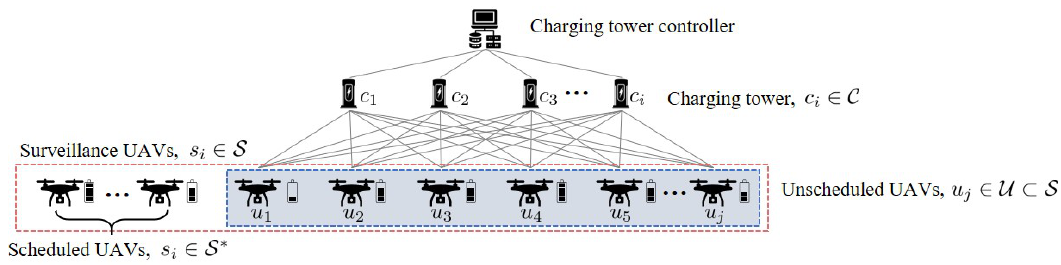
Figure 1. System model for the unscheduled unmanned aerial vehicles (UAVs) in terms of charging tower scheduling and wireless energy transfer